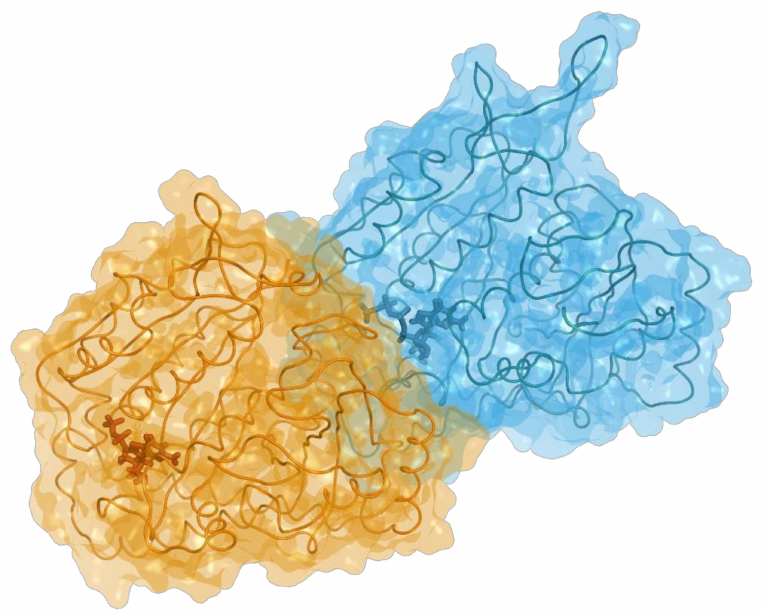
Figure 1. Structure of the tubulin heterodimer in complex with GTP (blue) at the nonexchangeable site and GDP (orange) at the exchangeable site on β . Figure generated using MOE v2022.02 software package